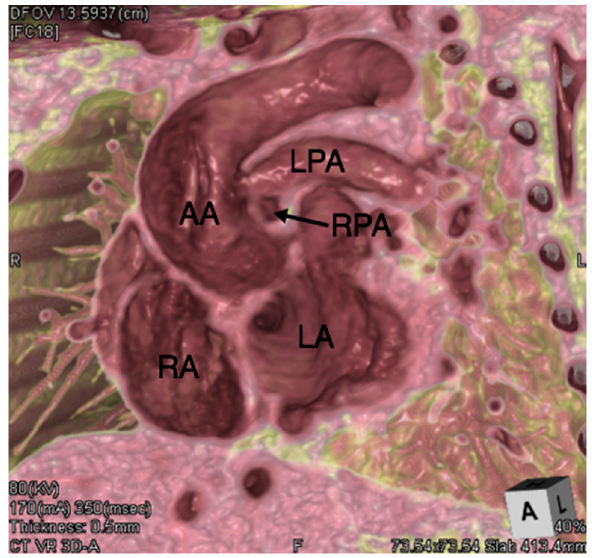
Figure 10. Computed tomographic 3D “virtual dissection” reconstruction in short axis of the atria demonstrating an anomalous left pulmonary artery (LPA) from the ascending aorta (AA) in a patient with tetralogy of Fallot. The right pulmonary artery (RPA) which arises from a hypoplastic pulmonary trunk is itself demonstrated to be hypoplastic. LA, left atrium; RA, right atrium.